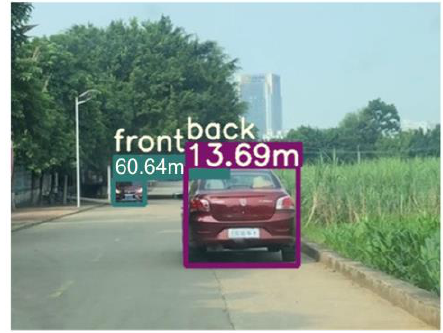
Figure 9. The effect of model output. Table 4. Results of distance measurement experiment.